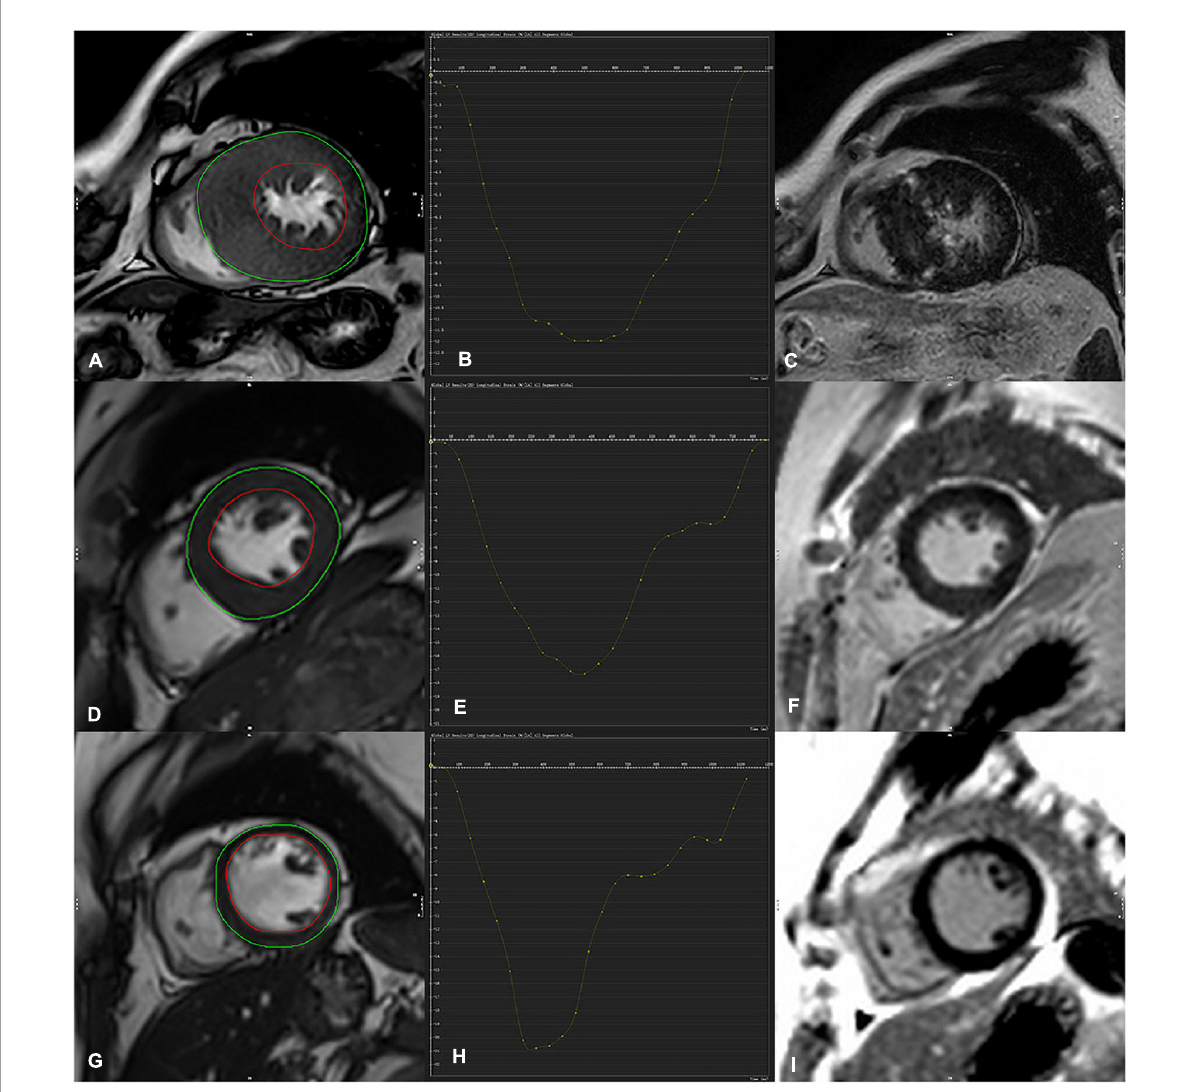
FIGURE2 Contouring for left ventricular (LV) strain, global longitudinal strain (GLS) derived from cine images (A,D,G) (both endocardial and epicardial boundaries automatically delineated) (C,F,J) were corresponding LGE image. (D–F) Indicated a representative case of LV tracking in the short-axis view in a 36-year-old-male HCM patient with no LGE and a 52-year-old male HCM patient with LGE positive (upper row A–C ), GLS in HCM LGE + patients significantly decreased in comparison with LGE- and a control subject (GLS = –12.0, –17.3, –21,